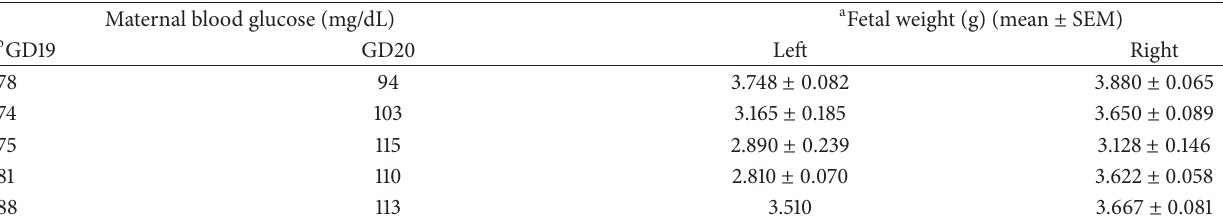
Table 3: Per dam maternal blood glucose and fetal weight.